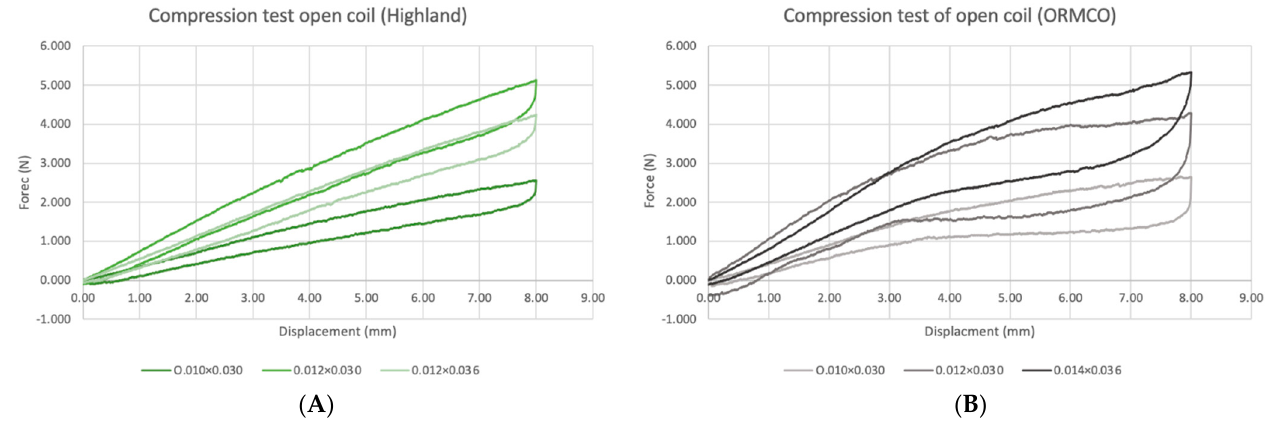
Figure 6. Load–displacement curves of NiTi open-coil springs of different manufacturers and dimensions. ( A ) The Highland group; ( B ) the ORMCO group.